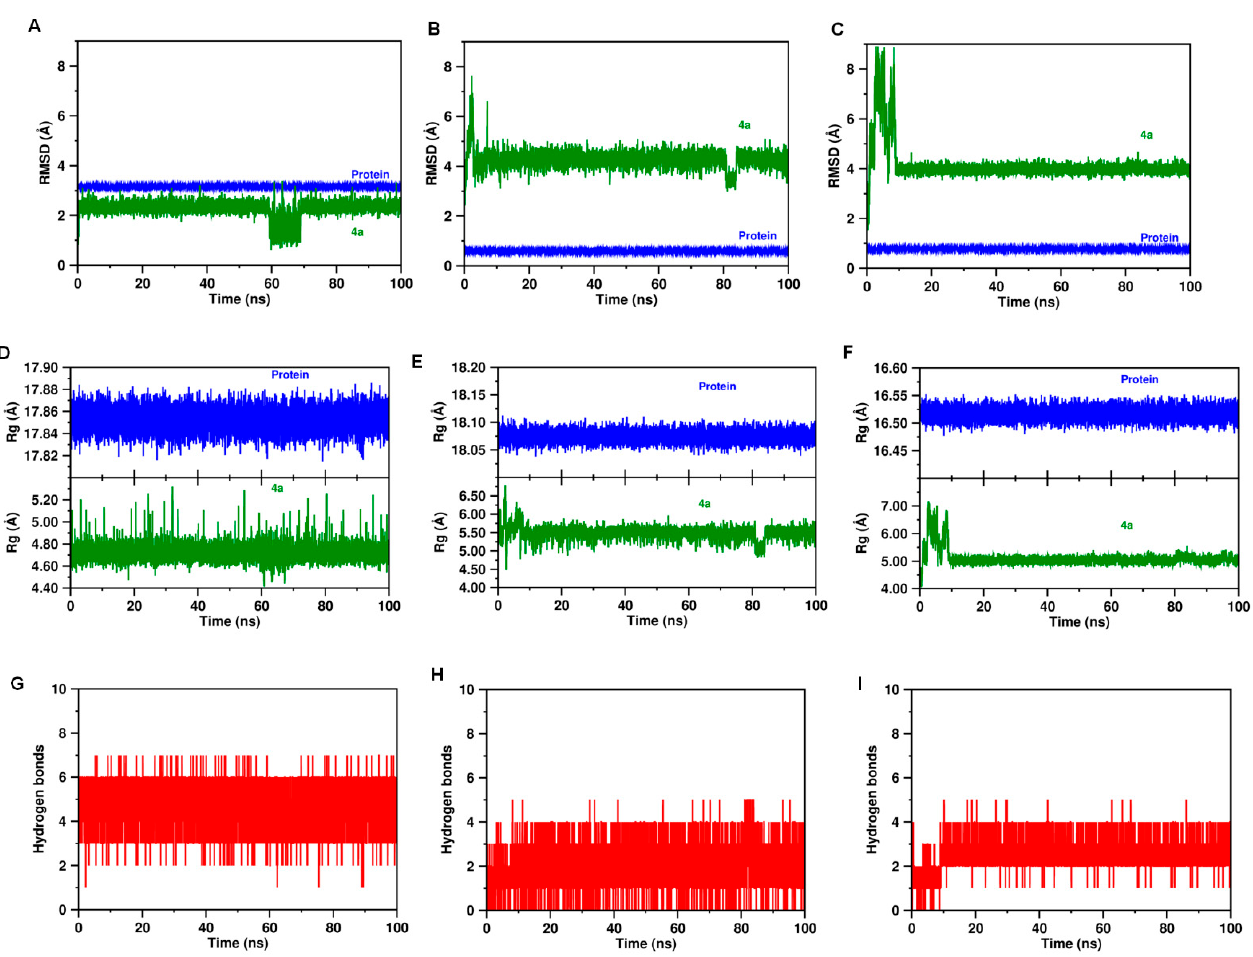
Figure 12. 100 ns MD simulation of ( A ) caspase-3 ( B ) caspase-8 ( C ) p53, in complex with 4a into the binding pocket (in green), and protein without ligand (in blue). Radius of gyration (Rg) plots of ( D ) 4a /caspase-3 complex ( E ) 4a /caspase-8 complex. ( F ) 4a /p53 complex. Plot of hydrogen bond formation during the MD simulation period of ( G ) 4a /caspase-3 complex ( H ) 4a /caspase-8 complex ( I ) 4a /p53 complex.